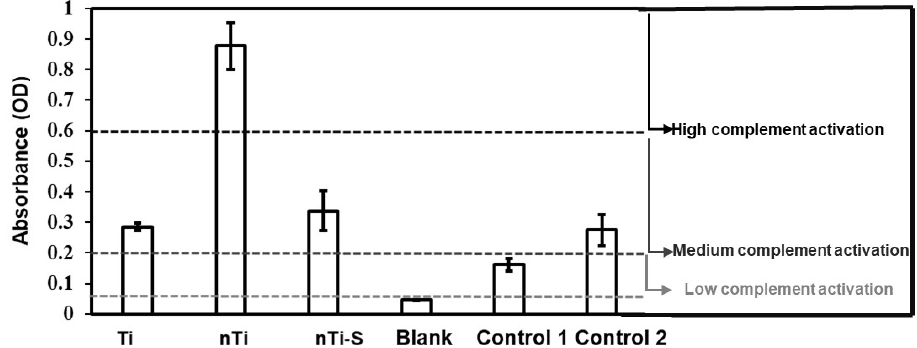
Figure 7. Complement activation of plasma incubated with different surfaces was measured as activation of complement convertase C5a. The lines indicate the regions of inactive/low ( ≤ 0.2), medium (>0.2 and ≤ 0.6), and high (>0.6) reactivity. (n min = 9.)